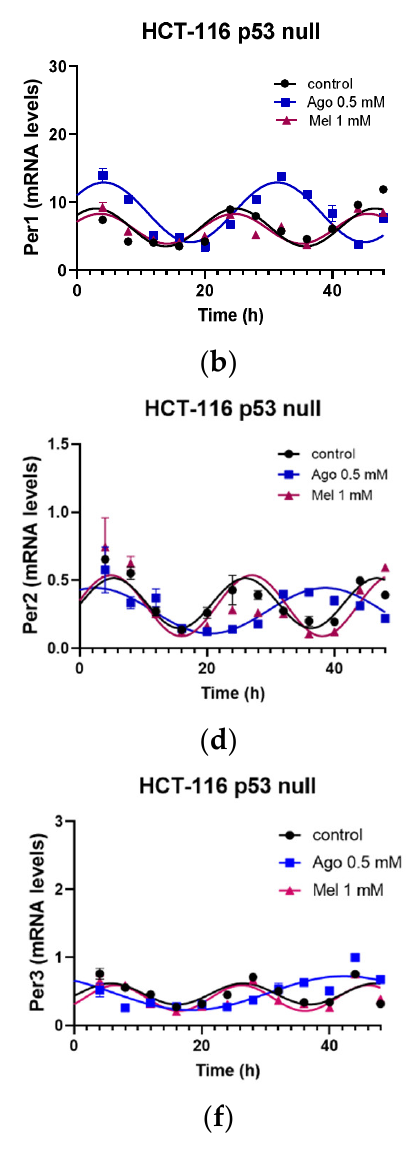
Figure 5. Expression levels of p53-protein in response to the treatments ( a ) with 0.5 mM agomelatine (Ago) and 1 mM melatonin (Mel) in the in vitro model, and ( b ) with agomelatine (Ago), melatonin (Mel), and 5-5-fluorouracil (FU) in tumors derived from HCT-116 and HCT-116-p53-null cell lines.